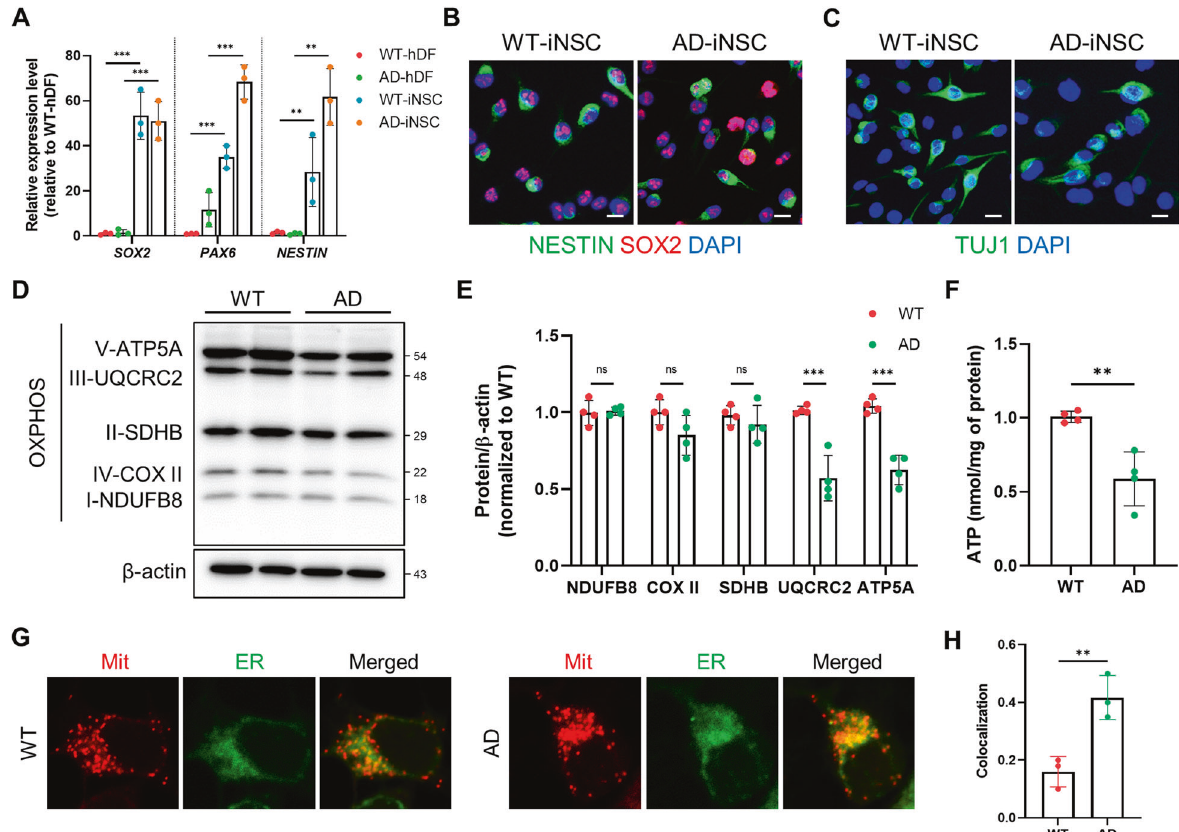
Fig. 1 Mitochondria abnormalities in AD-iNSCs. A mRNA expression of neural progenitor-related markers using qRT – PCR. The relative expression levels of SOX2, PAX6 , and NESTIN in WT-hDFs, AD-hDFs, WT-iNSCs, and AD-iNSCs. B Immunostaining of NESTIN (green) and SOX2 (red) in WT- and AD-iNSCs. Nuclei were detected with DAPI. Scale bar, 10 µm. C Immunostaining of TUJ1, an early neuron marker, in WT- and AD-iNSCs. D Western blotting of mitochondrial oxidative phosphorylation subunits (OXPHOS) in total cell extracts of WT- and AD-iNSCs using OXPHOS cocktail antibodies. E Quanti fi cation of the levels of ATP5A, UQCRC2, SDHB, COX-II, and NDUFB8 in WT- and AD-iNSCs. F The levels of ATP production in WT- and AD-iNSCs. G Mitochondria (Mit) and ER distribution of WT- and AD-iNSCs stained with MitoTracker and ER-Tracker. H Quanti fi cation of colocalization using ImageJ in WT- and AD-iNSCs. Statistical analysis was performed by Student ’ s t -test. * P < 0.05, ** P < 0.01, and *** P < 0.001. The results are presented as the means ±